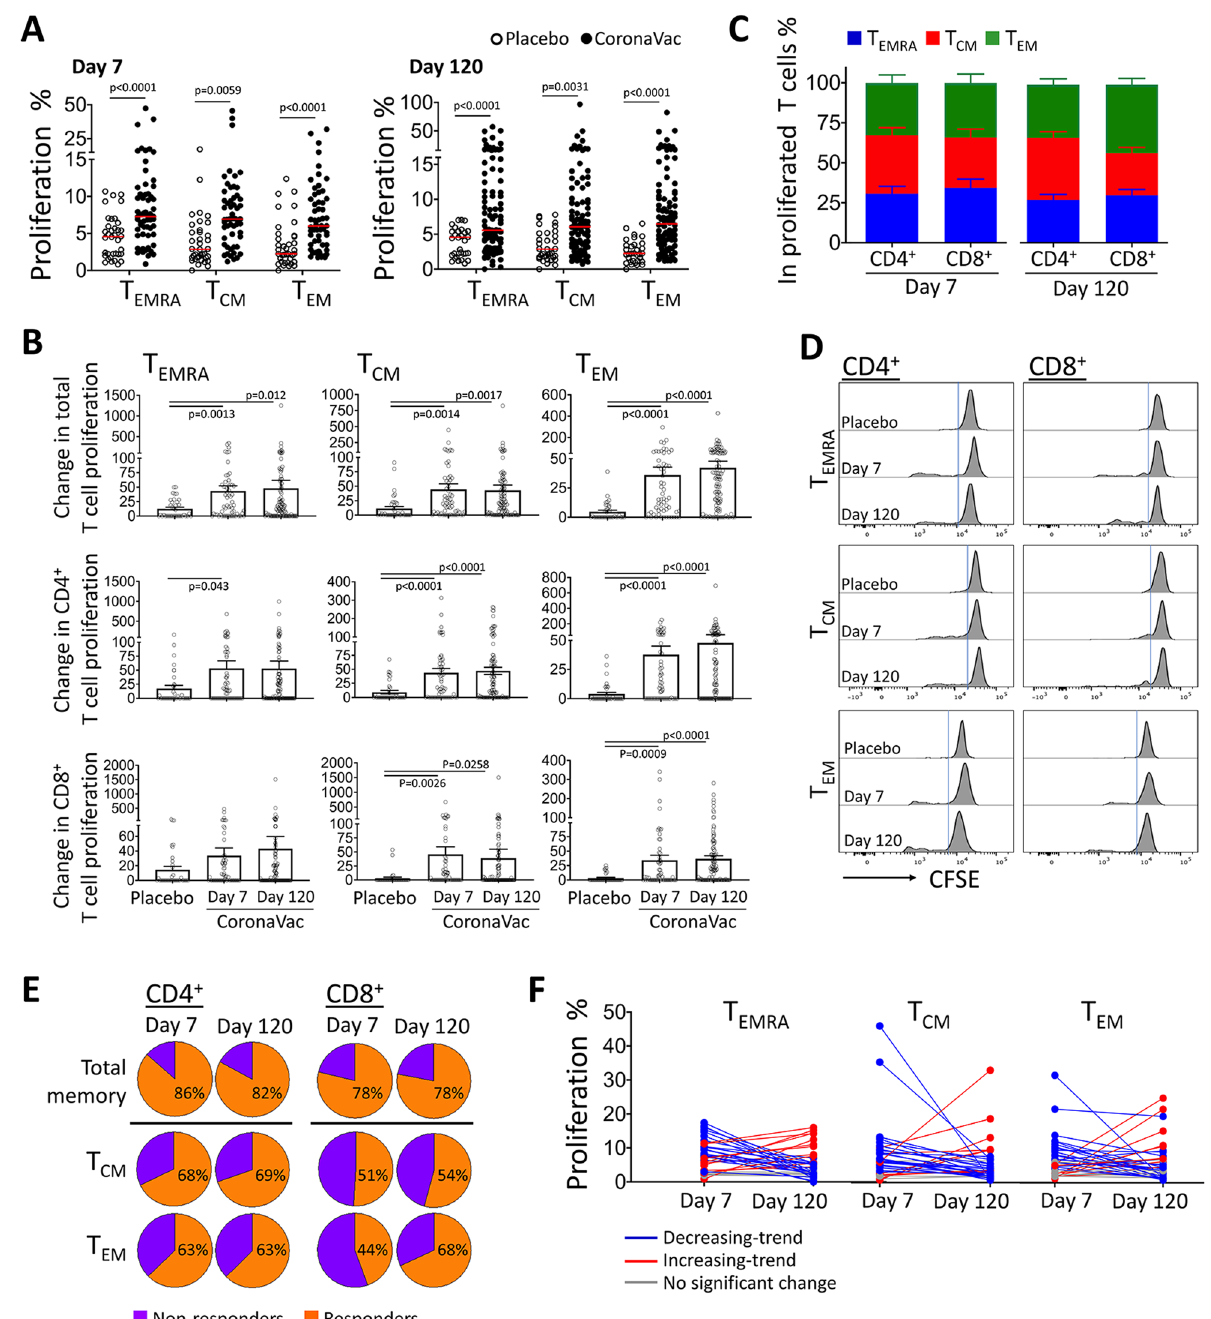
Figure 1. Proliferation responses in memory T cells from the individuals after the aluminum-adjuvanted inactivated whole-virion SARS-CoV-2 vaccination demonstrated a considerable response against S1 antigen. Autologous monocyte-derived dendritic cells were loaded with SARS-CoV-2 Spike Glycoprotein-S1 and co-cultured with terminally-differentiated effector T (T EMRA ), central memory T (T CM ), and effector memory T (T EM ) cells purified from the individuals after the second dose of CoronaVac (n = 48 on day 7 and n = 81 on day 120) or placebo administration (n = 34) on day 7 and day 120. Data obtained from the experiments without any technical complications are plotted; therefore, the number of volunteers for each group do not match to those of the total number of participants enrolled to the study. ( A ) Percentage of proliferation in memory T cell subsets is shown for each case. ( B ) Change in CD4 + and CD8 + memory T cell proliferation was calculated in comparison to the T cells co-cultured with non-specific antigen- loaded mDCs (without S1 antigen loading). ( C ) Contribution of each memory T cell subset to the overall proliferation response in CD4 + and CD8 + cells. ( D ) Flow cytometry histograms displaying representative proliferation responses from T cell subtypes are shown. ( E ) The percentage of participants whose T cells were responded to S1-loaded mDCs and proliferated more than the median value of the placebo group is demonstrated as “responders”. ( F ) The proliferation of T EMRA , T CM , and T EM obtained on day 7 and day 120 is given on individual basis (n = 32). (Significance was determined by Mann–Whitney U test for ( A ) and One-Way ANOVA for (B), *p < 0.05, **p < 0.01). Each dot represents a single